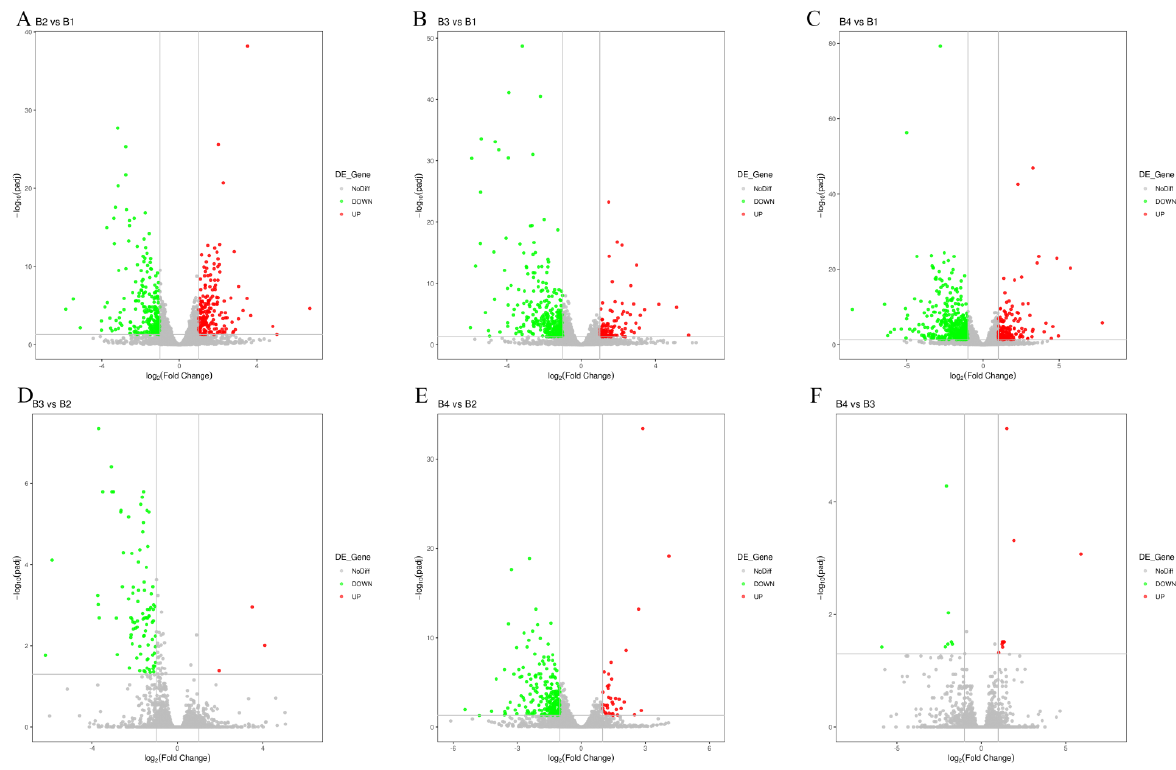
Figure 4. Overview of DEGs analyses for different light intensity treatments. ( A ) Volcano plot of significant DEGs between B2 vs. B1. ( B ) Volcano plot of significant DEGs between B3 vs. B1. ( C ) Volcano plot of significant DEGs between B4 vs. B1. ( D ) Volcano plot of significant DEGs between B3 vs. B2. ( E ) Volcano plot of significant DEGs between B4 vs. B2. ( F ) Volcano plot of significant DEGs between B4 vs. B3.